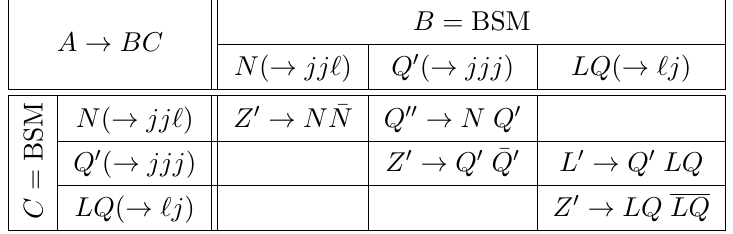
Example (Group X in table 1) for A ! BC , where A , B and C are BSM particles. Both B and C decay to more complex (cid:12)nal states. The N denotes a right-handed heavy neutrino which can decay into N ! W 0 ( (cid:3) ) ‘ ! jj‘ . The Q 0 represents a generic vector-like quark decaying to Q 0 ! W 0 ( (cid:3) ) j ! jjj .